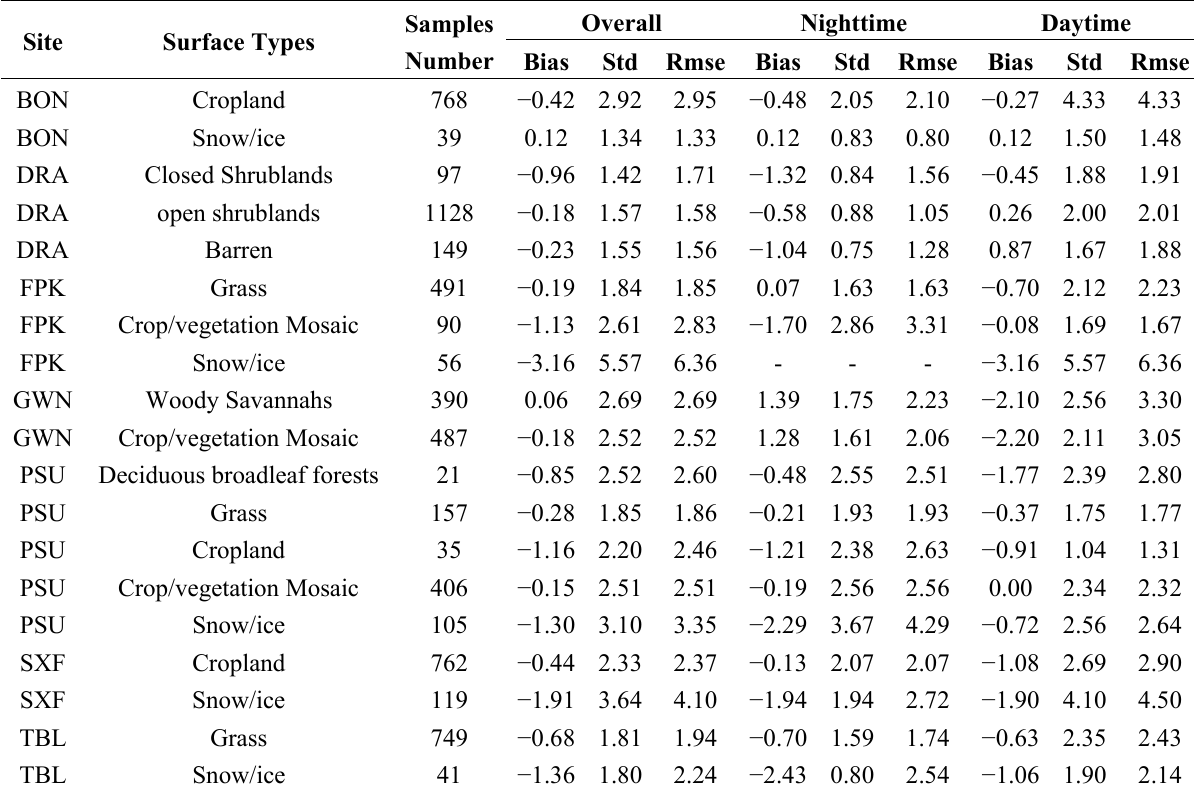
Table 5. Discrepancies between VIIRS LST and Ground LST over site and associated surface